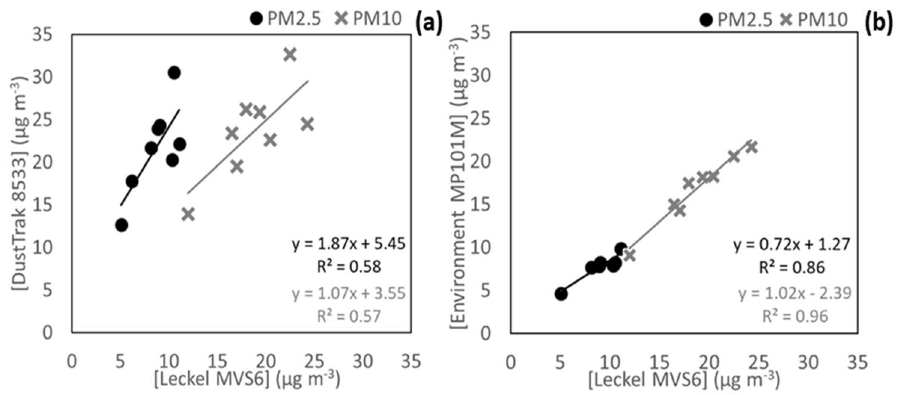
Figure 3. ( a ) Correlation between the gravimetric PM mass concentrations and the DustTrak 8533 and ( b ) the Environment MP101M measurements.